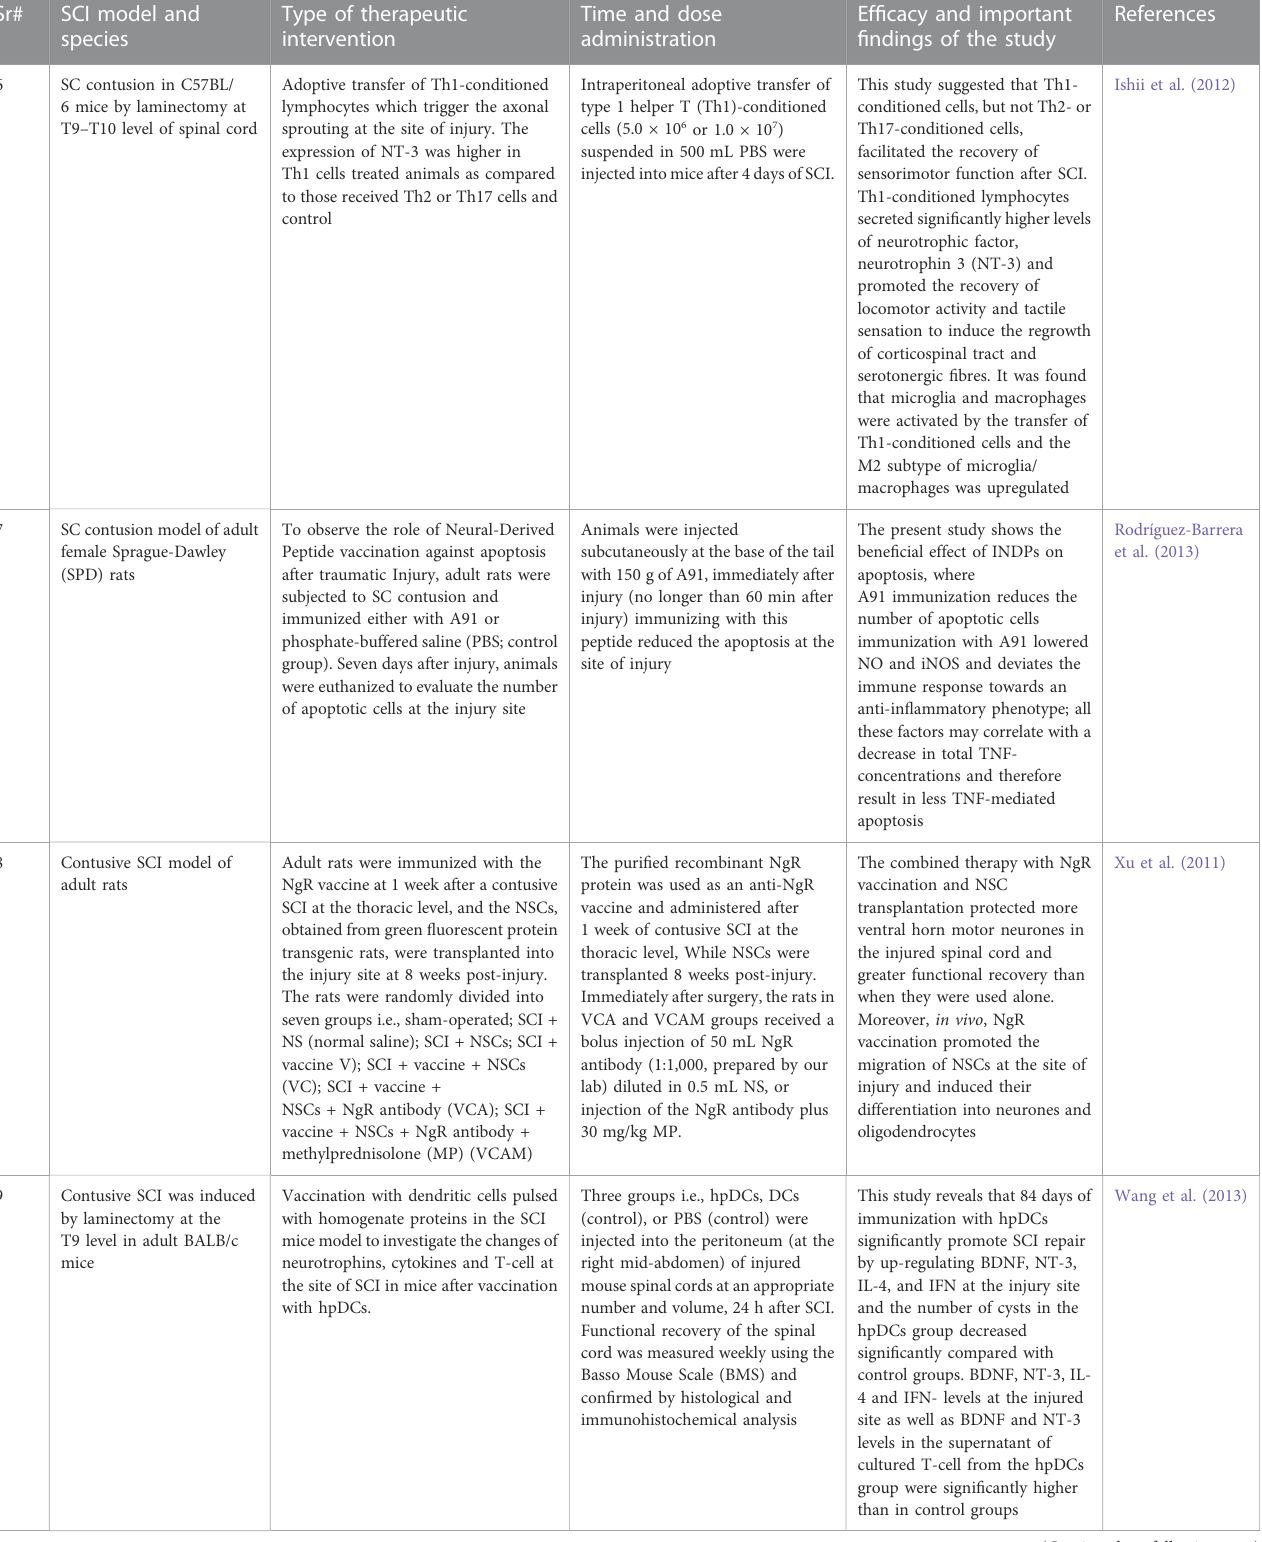
TABLE 1 ( Continued ) Summary of studies using immunotherapy to treat spinal cord